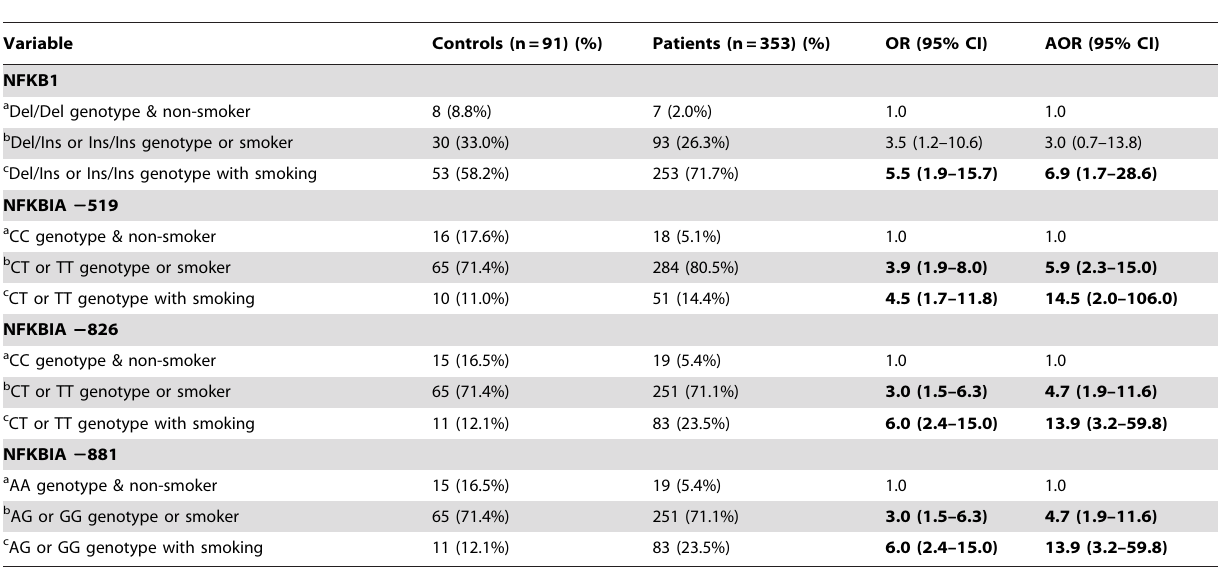
Table 4. Adjusted odds ratio (AOR) and 95% CI for oral cancer associated with NFKB and NFKBIA genotypic frequencies and cigarette smoking among 444 betel nut consumers.